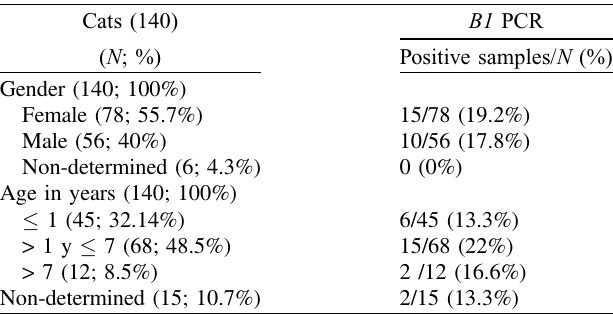
Table 2. Comparison of PCR T. gondii prevalence in cat feces according sex and age (years) in the 140 cats from which the samples were taken in 10 communes from Armenia.